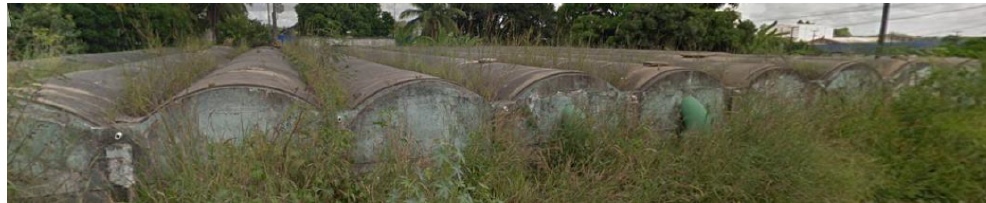
Figure 11. Support reservoirs. Source: Google Maps.